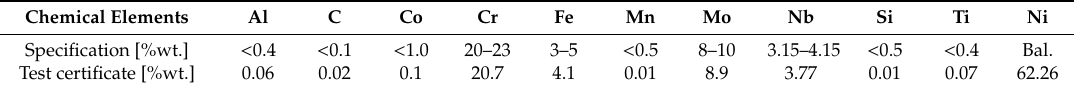
Table 1. Chemical composition of IN 625 metal powder provided by LPW Technology Ltd. Chemical Elements Al C Co Cr Fe Mn Mo Nb Si Ti Ni Specification [%wt.] <